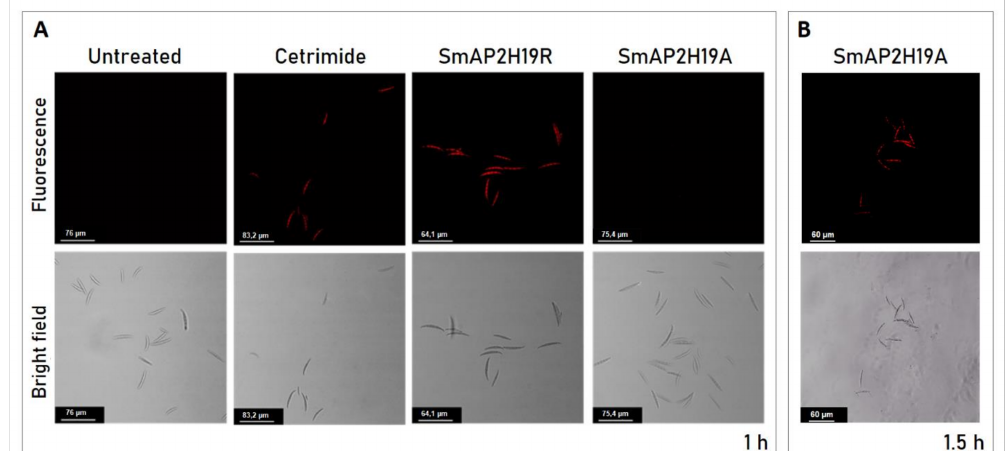
Figure 5. ( A ) Bright field (bottom) and fluorescence (above) images of Fusarium graminearum conidia incubated with peptides SmAP2H19R and SmAP2H19A at their MIC for 1 h. Cetrimide was used as positive control. ( B ) Bright field (bottom) and fluorescence (above) images of F. graminearum conidia incubated with SmAP2H19A at its MIC for 1.5 h. Bar indicates size in µ m.